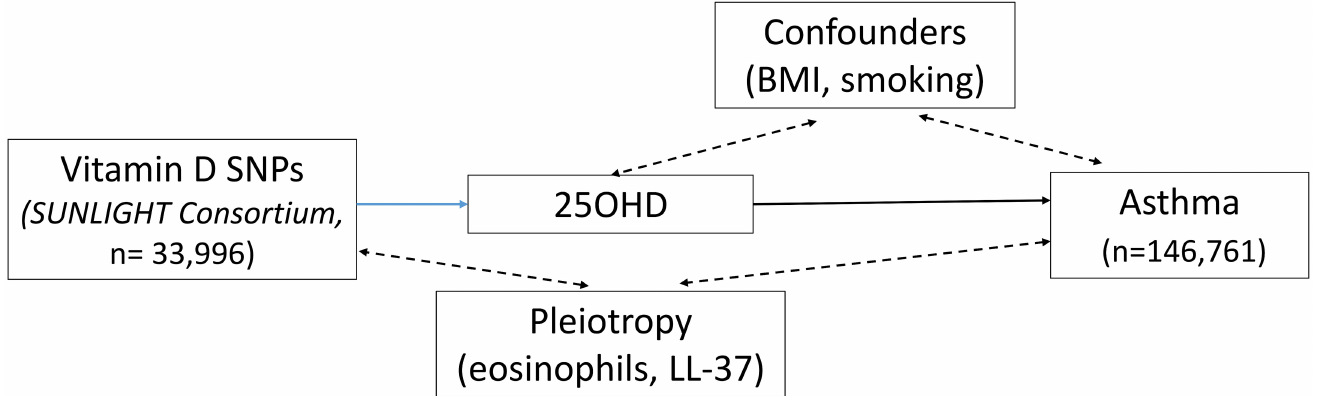
Fig 1. Direct Acyclic Graph (DAG) of the Mendelian randomization analysis for asthma. The effect of single-nucleotide polymorphisms (SNPs) on the changein natural log-transformed 25-hydroxyvitamin D (25OHD) levels. BMI, body mass index; SUNLIGHT, Study of Underlying Genetic Determinants of Vitamin D and Highly RelatedTraits.